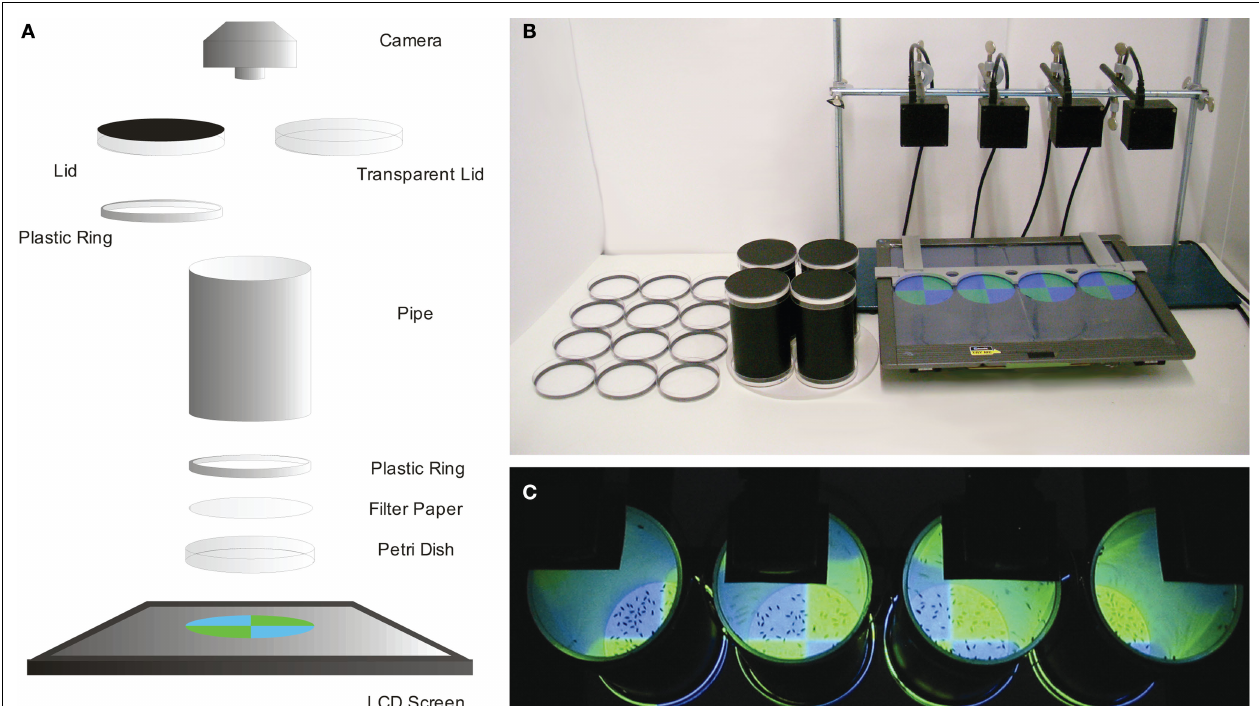
a transparent lid enables recording fl ies from above. (B) The setup. From left to right: Petri dishes with fi lter papers (US-soaked, water-soaked and neutral from the left), cylinders closed with the opaque lids (top and bottom), the LCD screen with a plastic frame presenting test visual stimuli, cameras fi xed by a stand. (C) Top view during the test phase. The fl ies are recorded with cameras from above (black